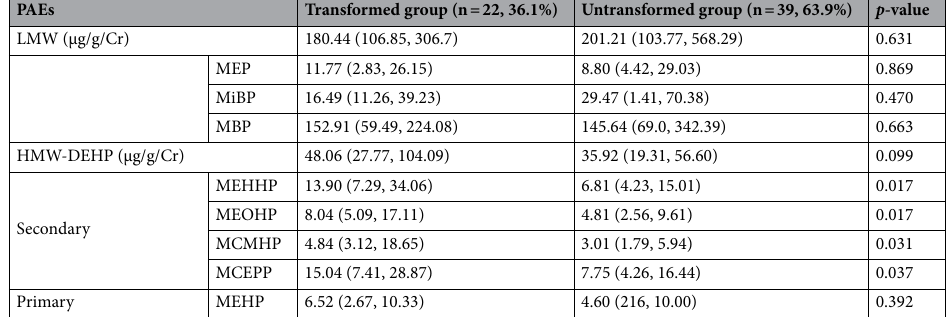
IPT progression. Compared to IPT with breast Tanner stage 2, IPT with breast Tanner stage 3 had a 7.041-fold higher risk of progressing to CPP/EP within one year. For each 1 mL increase in the ovarian volume and 10 µg/g/ Cr increase in the urine level of Σ 4 DEHP, the risk of progression from IPT to CPP/EP within one year increased by 260% and 20%, respectively.